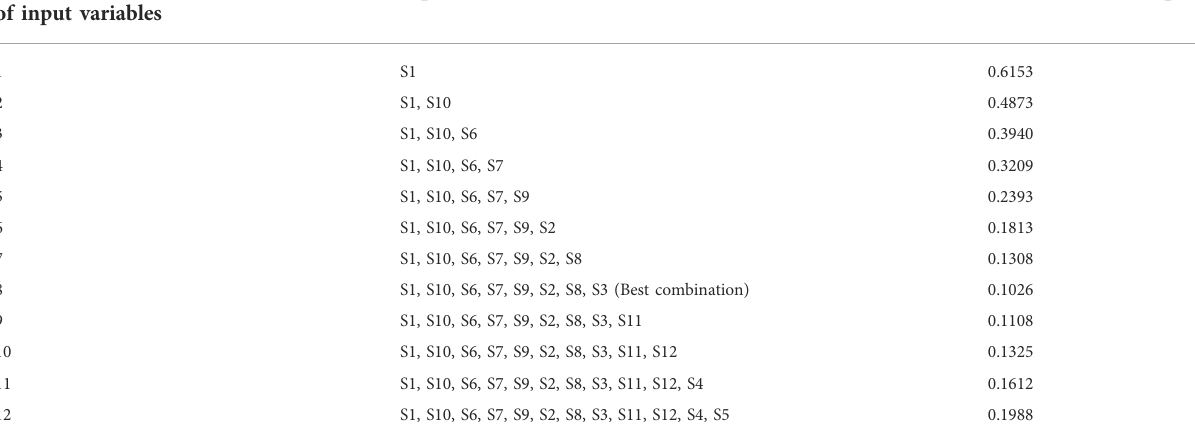
TABLE 4 Feature selection ’ s result to number of combination input variable for well #W1. Number of input